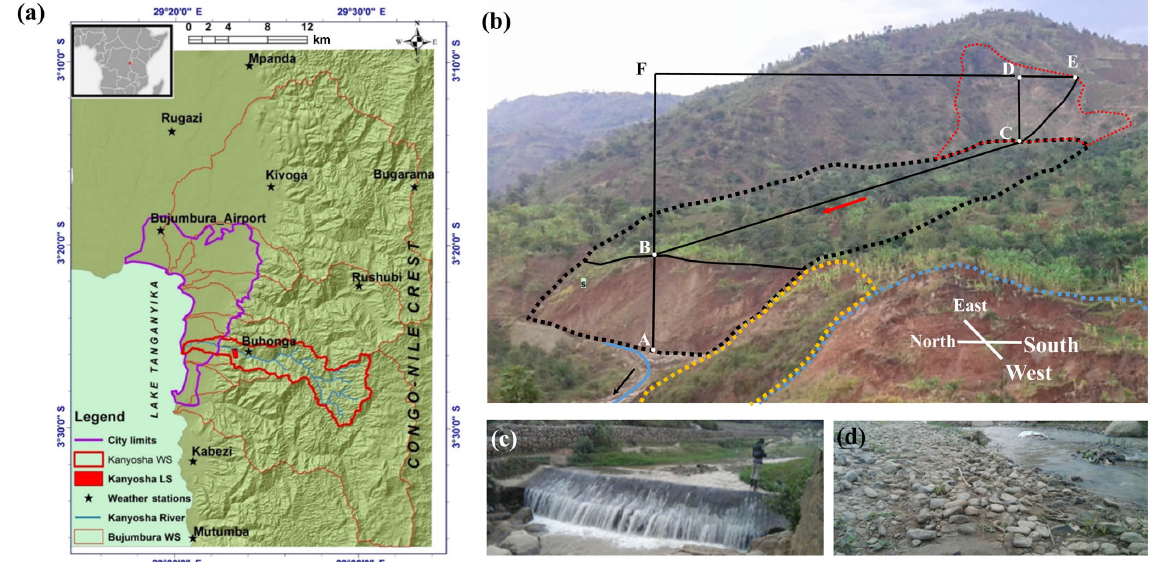
Figure 1. (a) Bujumbura region with indication of watersheds of the main rivers, the limits of the city and Lake Tanganyika. The watershed of the Kanyosha River is highlighted in the central part, with the river network inside. The weather stations in and around Bujumbura, the Kanyosha landslide (in the text called “Banana Tree Landslide”, also referred to as BTL, in red contours) and the Congo–Nile crest are also shown. “LS” and “WS” stand for “landslide” and “watershed”, respectively. (b) View of BTL (black dotted contour) and the main scarp (red dotted contour) as well as its lateral local instabilities (orange and light blue dotted contours). The landslide sliding direction and the river flow direction are indicated by the red and the black arrows, respectively. AB indicates the height (26m) of the landslide frontal part near the river; BC outlines the BTL length in the sliding direction ( ∼ 750m); CD shows the height of the main scarp ( ∼ 75m) along profile points B–C–E. The blue line indicates the river channel axis. (c) Waterfall over a former flood control structure (located 270m downstream of cross section 3 shown in Fig. 3). (d) View of the riverbed during the dry season with presence of cobbles and fine boulders that are deposited after floods during the wet